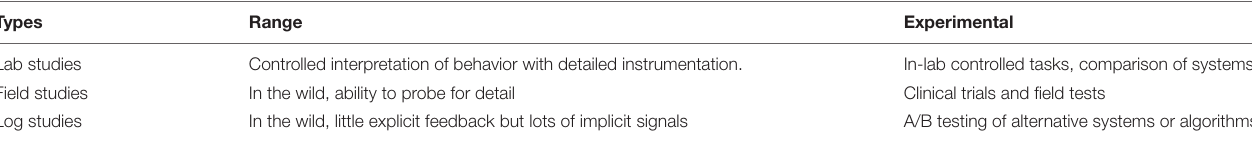
TABLE 1 | Different types of user data for improving